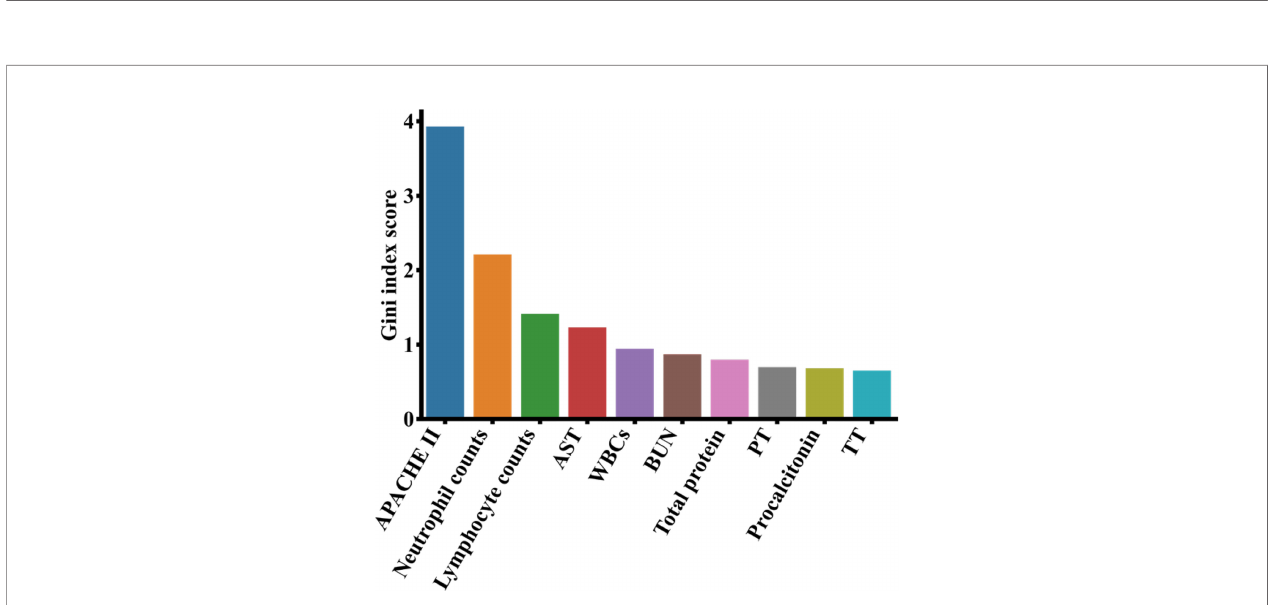
FIGURE 6 | Top 10 most important features from the XGBoost model on the COVID-19 data. APACHE II, acute physiology and chronic health evaluation I; AST, aspartate aminotransferase; BUN, blood urea nitrogen; PT, prothrombin time; WBC, white blood cell count; TT, thrombin